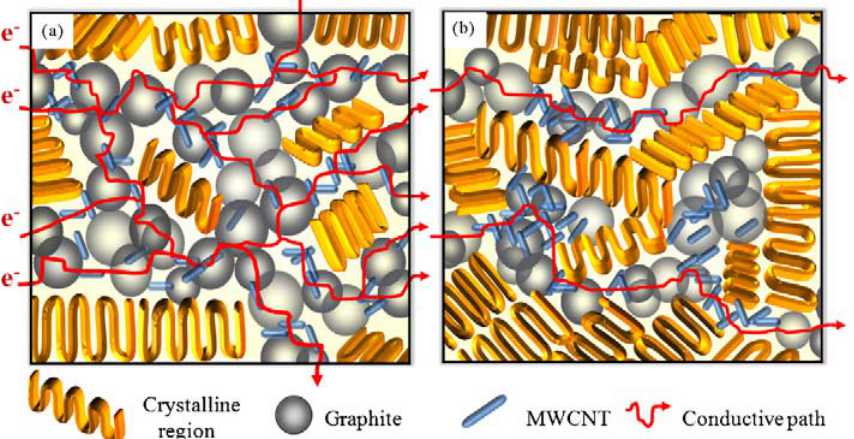
Figure 29. The model of conductive paths in the nanocomposite bipolar plates with (a) better dispersion of MWCNTs in LC-PP matrix (b) MWCNTs aggregation in HC-PP matrix. Reproduced with permission from ref.